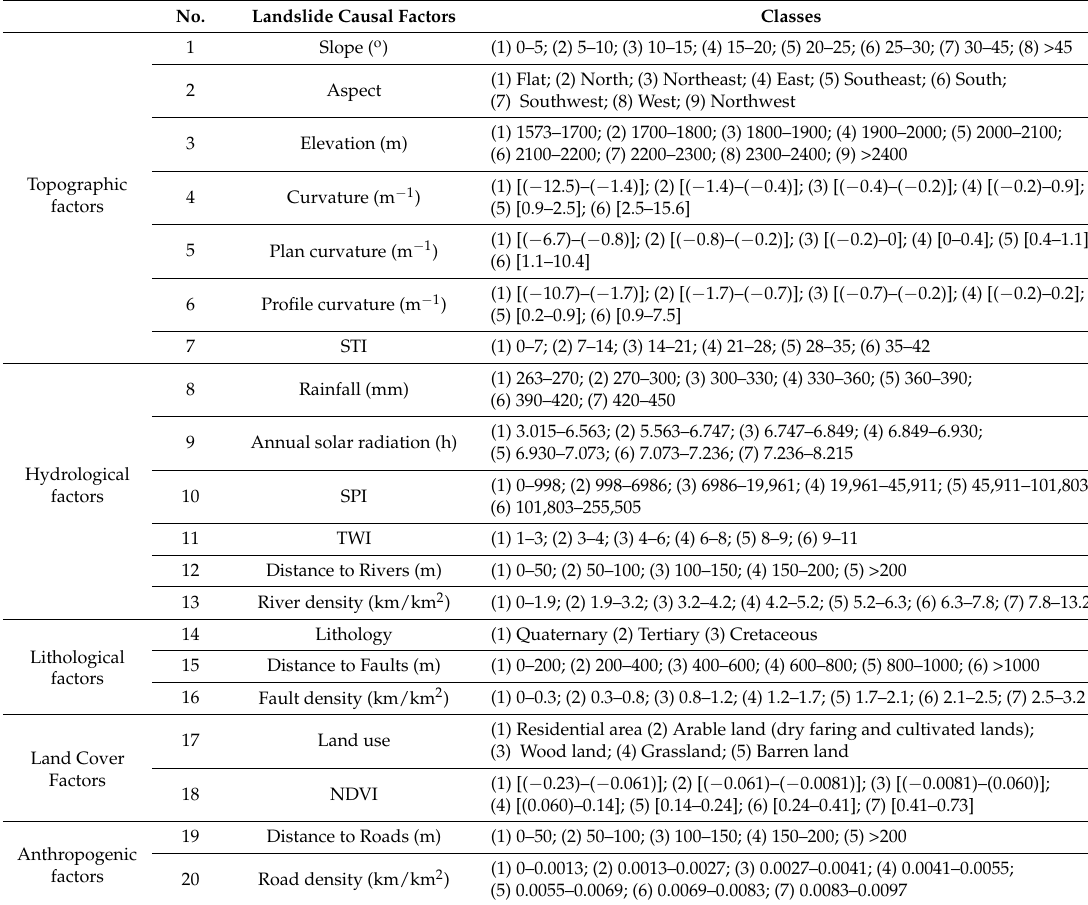
Table 1. Landside conditioning factors and their classes for landslide modeling in Bijar City.